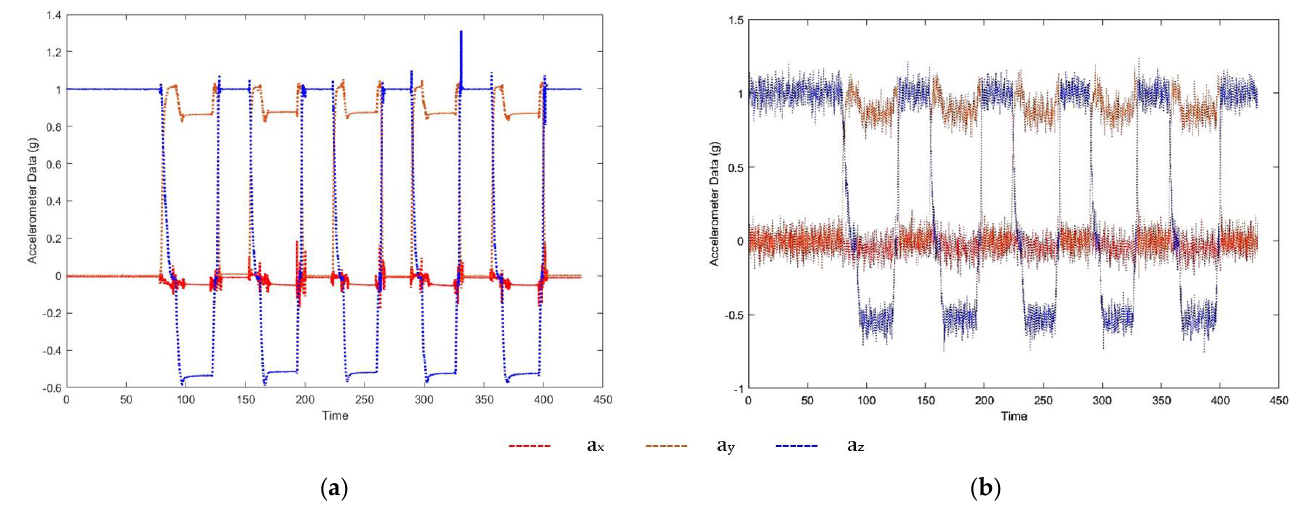
Figure 10. Raw accelerometer data ( a ) without noise and ( b ) with external noise.